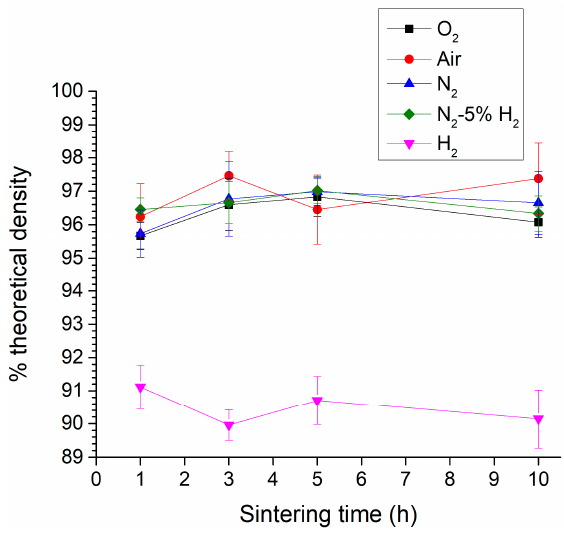
Figure 2. Archimedes density of KNbO 3 samples sintered at 1040 °C for 1–10 h in different atmospheres.